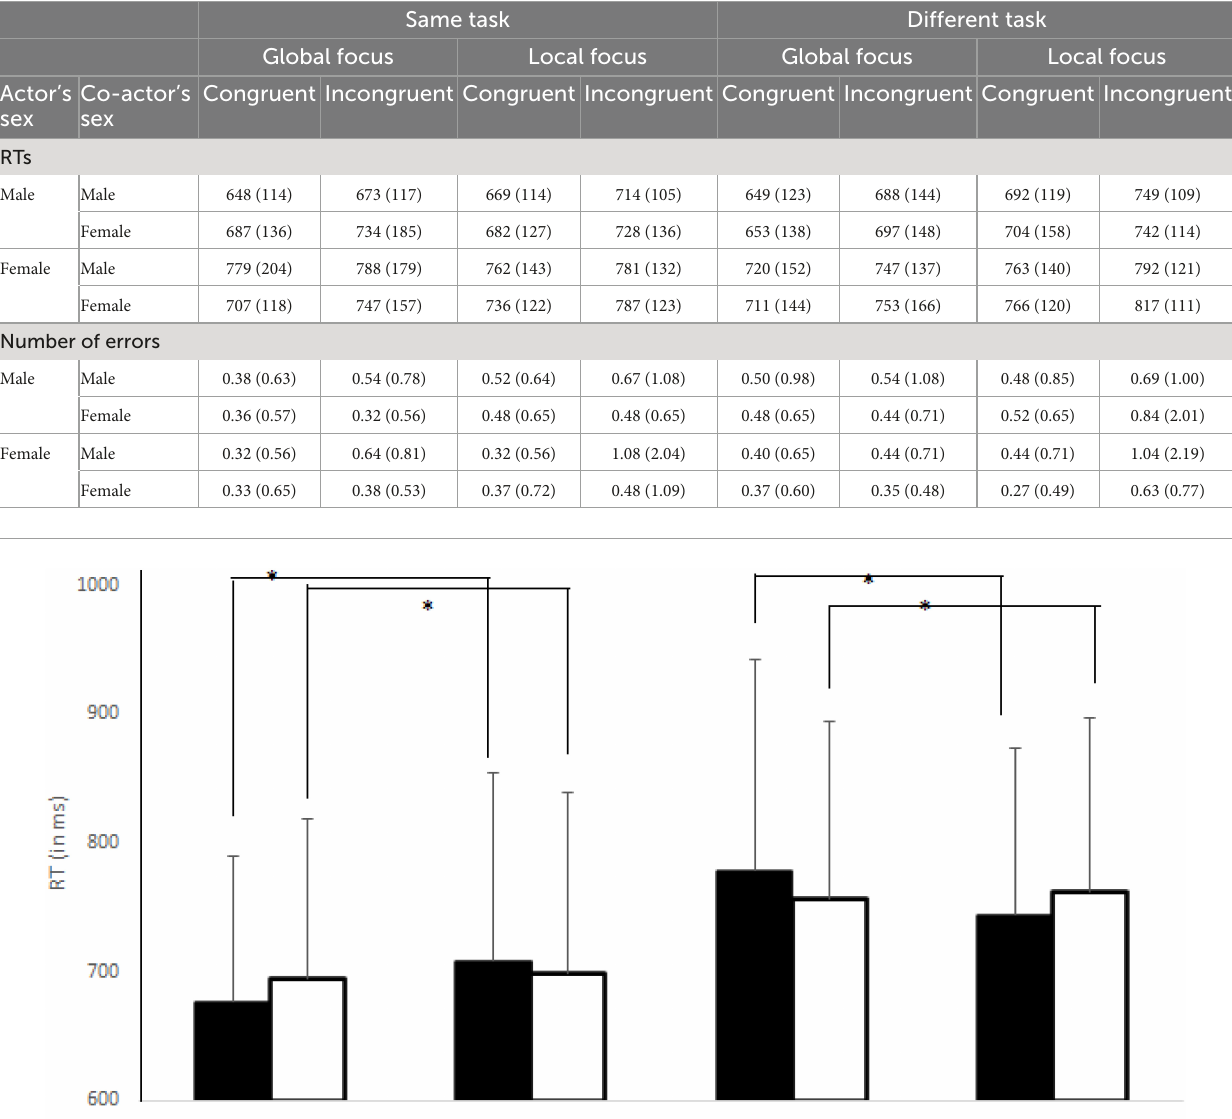
TABLE 2 The means (and relative SDs) of response times (RTs), in ms, (upper part) and number of errors (lower part) for congruent and incongruent trials in global and local focus of attention when the same and different attentional tasks were provided are displayed for each sex pair.